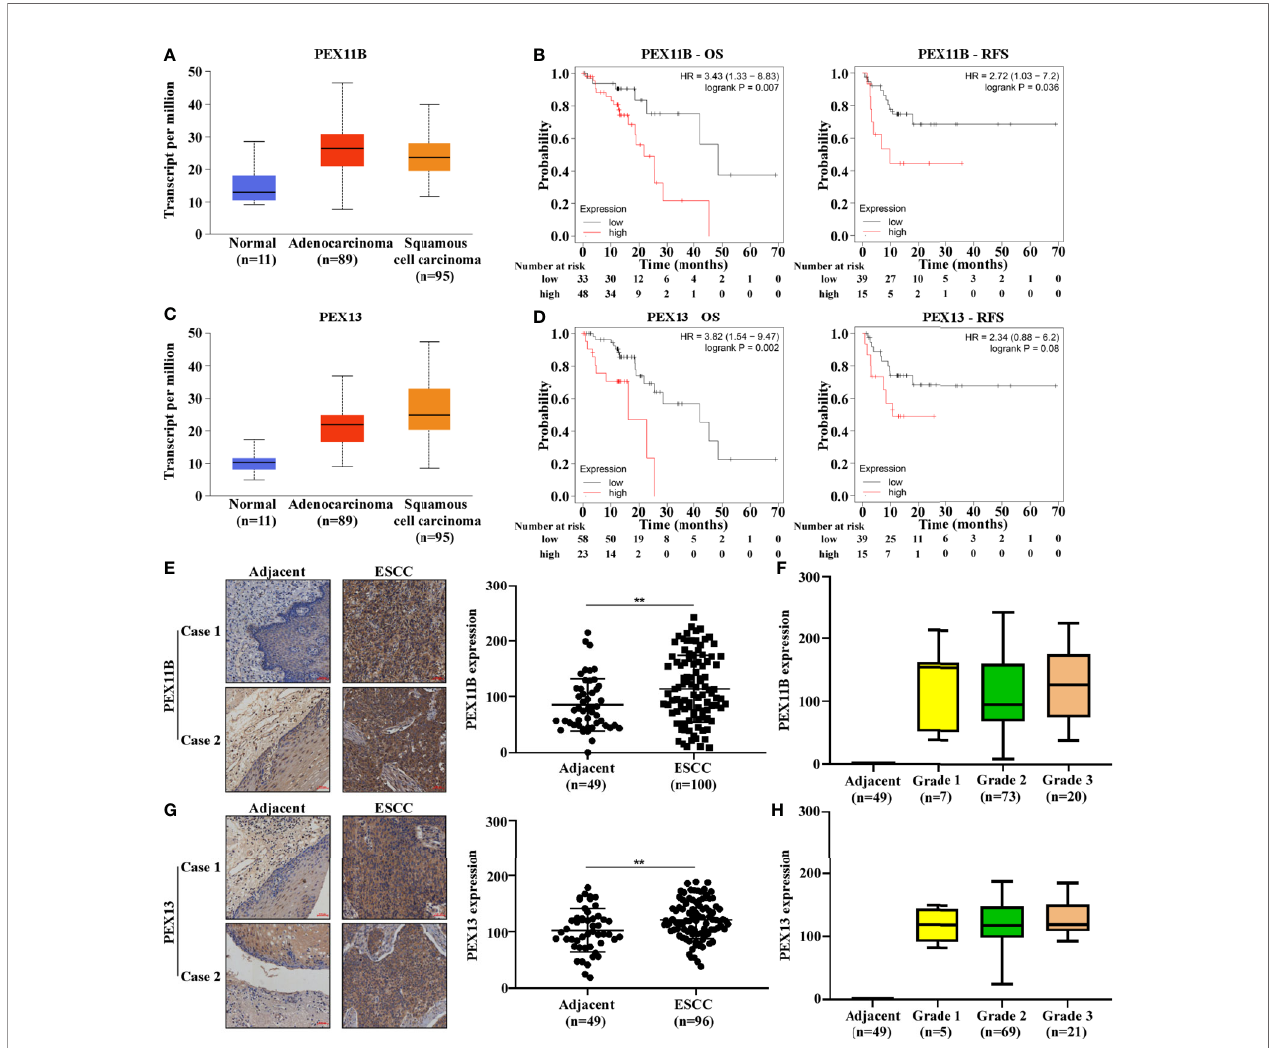
FIGURE 4 | The expression of PEX11B and PEX13 in ESCC are higher and are closely related to the prognosis of ESCC. (A) The expression level of PEX11B in ESCC from the TCGA database. (B) Kaplan – Meier curves of OS and RFS in patients with PEX11B high expression. (C) The expression of PEX13 in UALCAN. (D) Kaplan – Meier survival was used to show OS and RFS in PEX13 high expression patients. (E) Tissue microarray shows high expression of PEX11B in ESCC (** p < 0.01). The image on the left is representative. (F) The tumor grade in PEX11B high expression cases. (G) Representative staining images from PEX13 high expression tissues (left), and the scatter plot of PEX13 high expression in ESCC (right) (** p < 0.01). (H) The pathology grade in PEX13 high expression